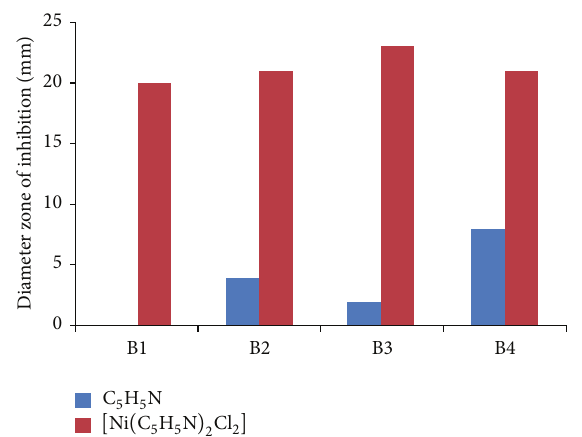
Figure 9: Bacterial growth inhibition by the tested ligand and